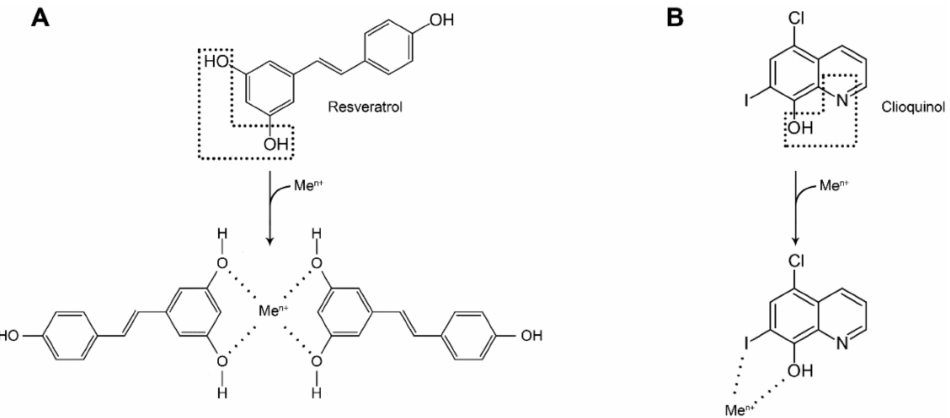
Figure 3. Resveratrol and clioquinol as metal-chelating agents. The proposed mechanisms of metal ion (Me n+ ) chelation by resveratrol ( A ) [104] and clioquinol ( B ) [108]. Dotted lines indicate functional groups responsible for metal